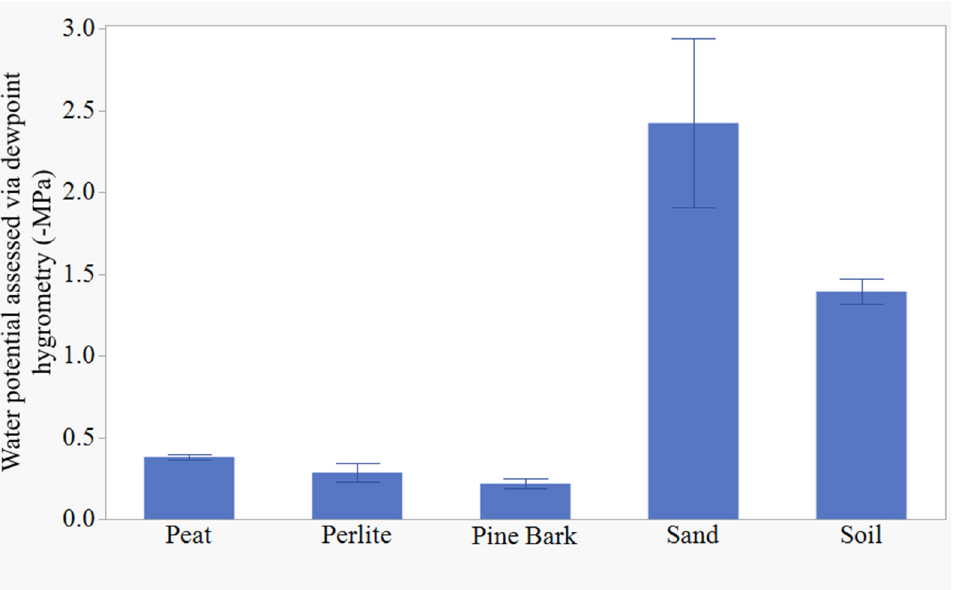
Figure 4. Substrate water potential of individual substrate and soil components assessed via dewpoint hygrometry, after being squeezed at − 1.5 MPa on ceramic pressure plates in a volumetric pressure plate extractor. Data utilized from Fields et al., 2013 [15].